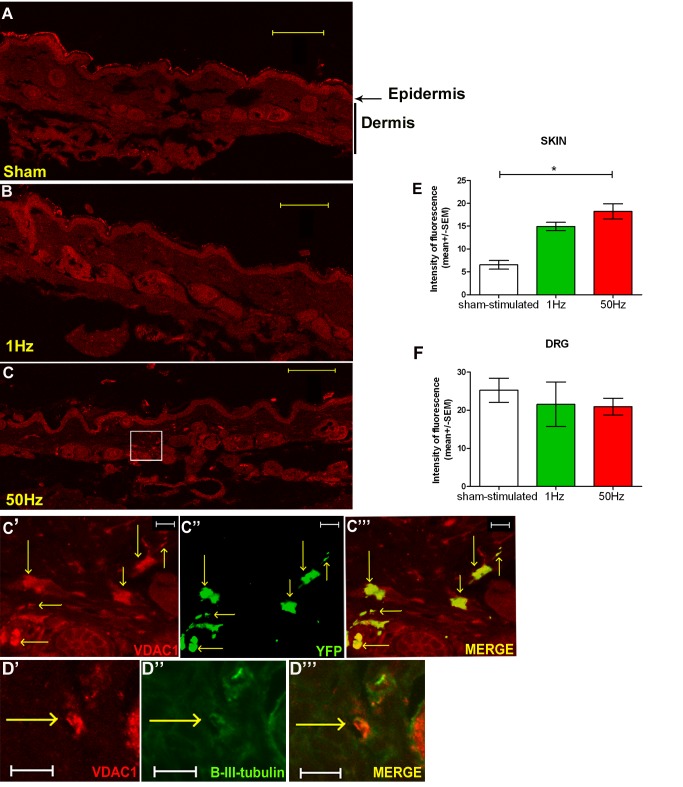
In saphenous nerve axons stimulated at high frequency (50 Hz) mitochondria accumulate at the peripheral sensory terminals.Skin innervated by saphenous nerve was immunohistochemically labelled with VDAC1 (red) and neuron-specific β-III-tubulin (green). In comparison with sham-stimulated animals (A), axons were strongly labelled for VDAC1 in nerves stimulated at 1 Hz (B) and 50 Hz (C). (C′–C′″) Saphenous nerve from a YFP+ mouse (shown in low power in C), which expresses YFP (green) in a proportion of fibres, was stimulated with 50 Hz and labelled with VDAC1 (red). (D′–D′″) Saphenous nerve from a YFP− mouse was stimulated with 50 Hz and double labelled with VDAC1 (red) and β-III-tubulin. The two markers were often found to co-localise. (E) Intensity of VDAC1 labelling was significantly higher within cutaneous fibres of saphenous nerve stimulated at 50 Hz (n = 5, p<0.05) than in sham-stimulated (n = 3) or fibres stimulated at 1 Hz (n = 3). (F) There was no difference in VDAC1 labelling intensity in DRGs of saphenous nerves between the groups. Scale bars in (A–C) = 100 µm, in (C′–C′″) = 20 µm, in (D′–D′″) = 10 µm.